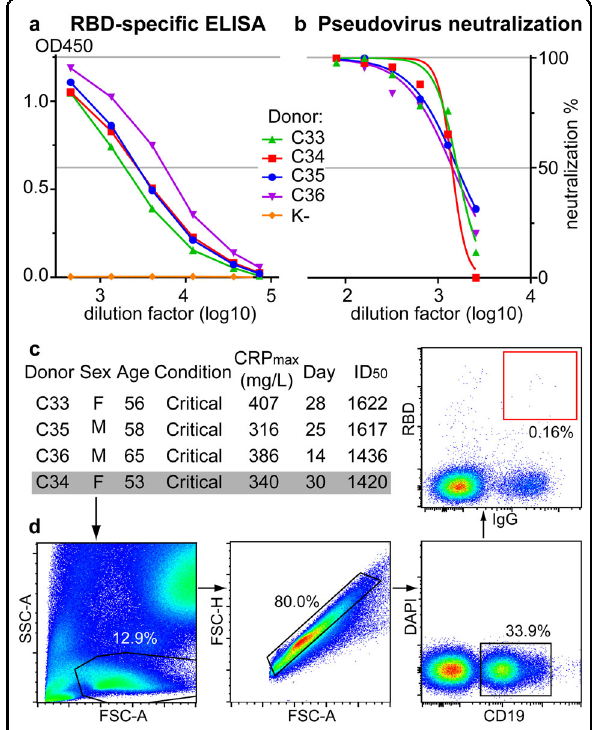
Fig. 1 Donor selection and sorting of RBD-speci fi c B lymphocytes from the blood of convalescent COVID-19 patients. a , b Sera of four select donors were characterized by ELISA for anti-RBD binding potency ( a ) and pseudovirus neutralization activity ( b ). K- stands for a healthy donor. c Short medical information for these donors. d Gating strategy used for selection of individual RBD + IgG + B lymphocytes, shown are the representative FACS plots for donor